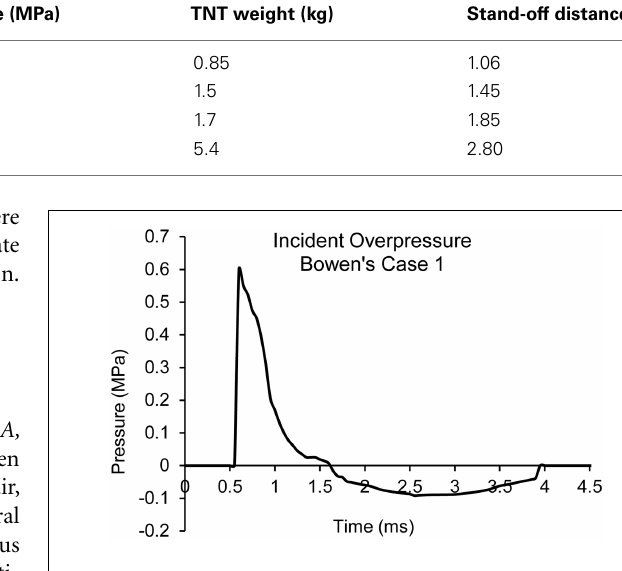
FIGURE 4 | Plot of blast pressure time history in the vicinity of the head for Bowen’s Case 1 .